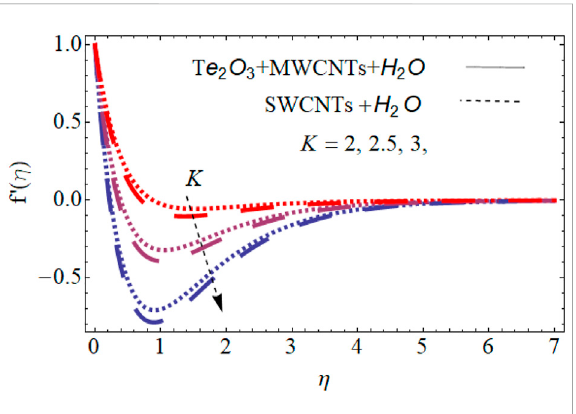
FIGURE 4 Inspiration of the couple stress parameter on the velocity pro fi le.